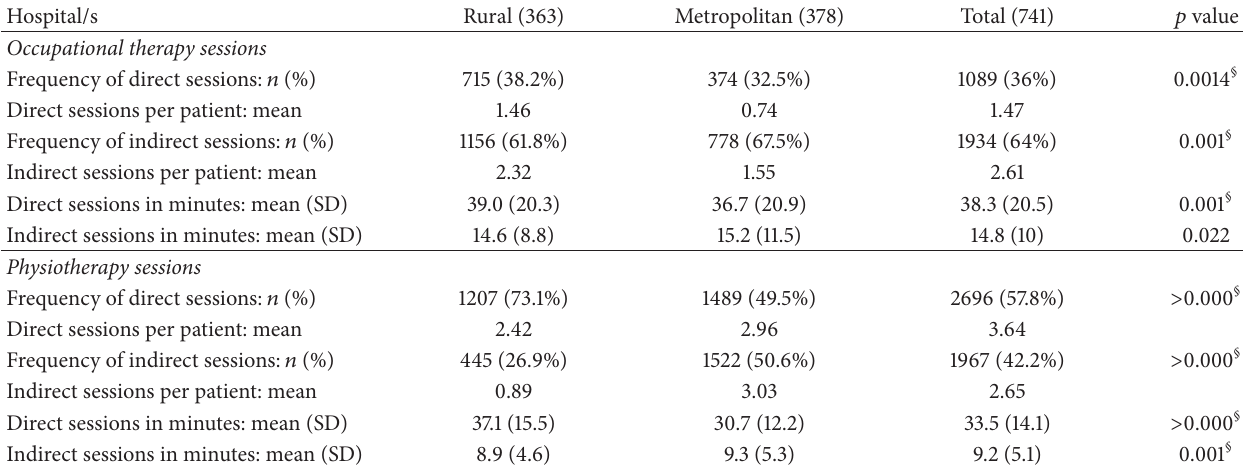
Table 3: Comparing frequency and duration of OT and PT sessions against type of session and